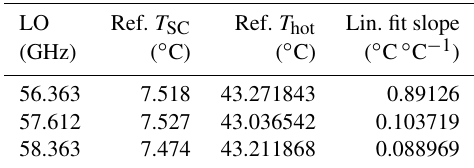
Table 5. Linear fit values used to correct the MTP hot target bright- ness